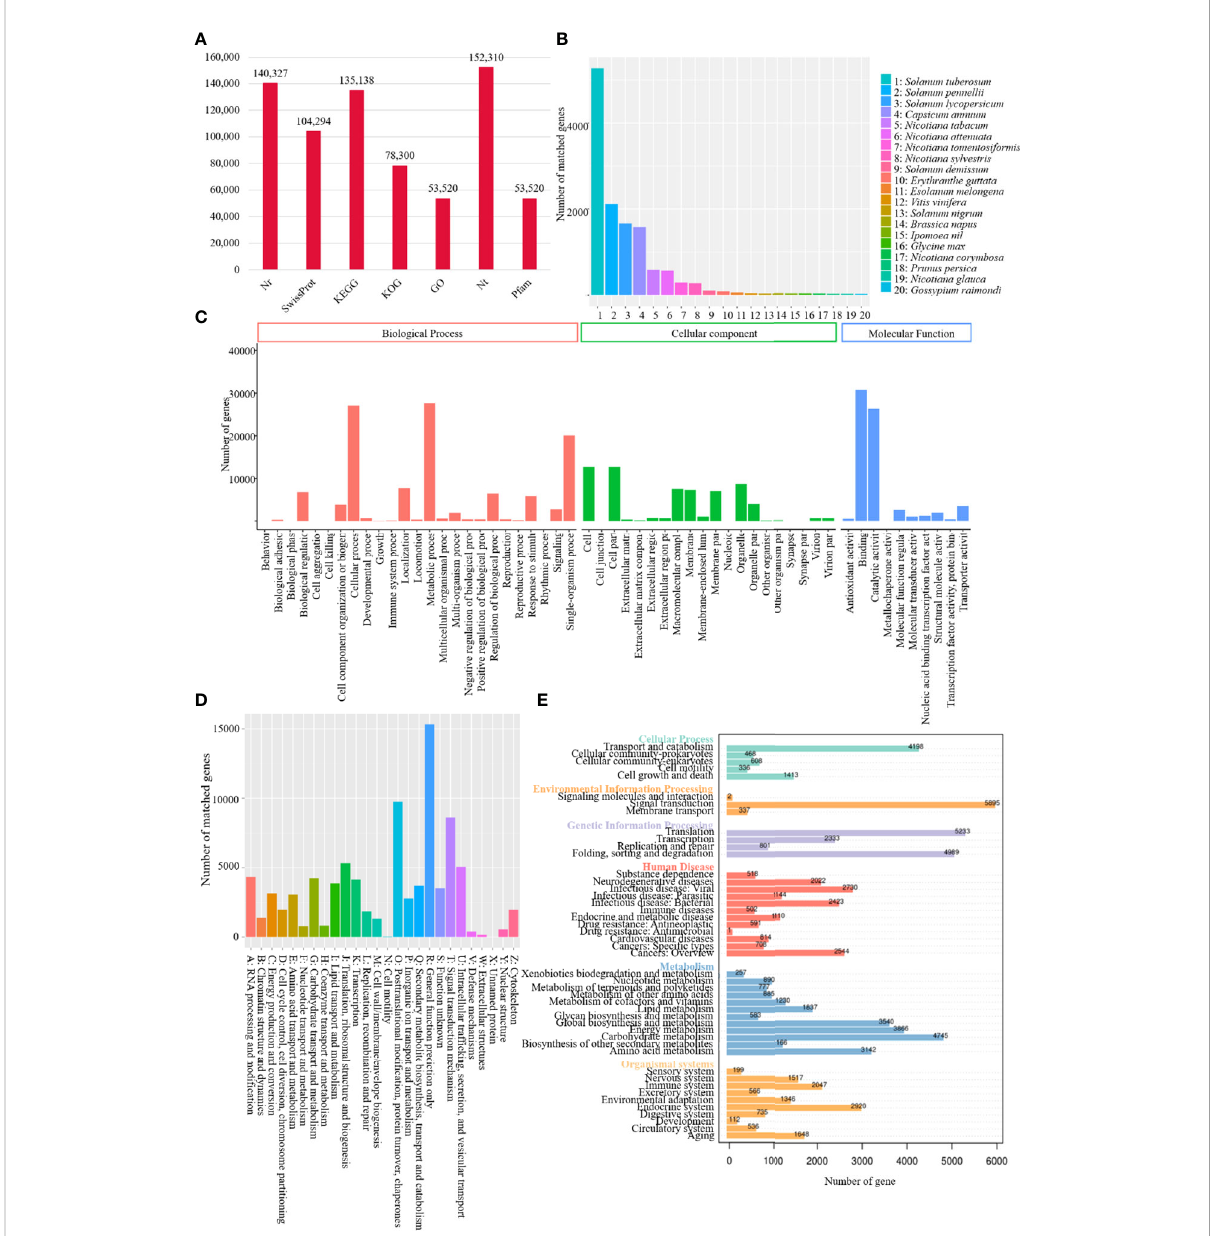
FIGURE 1 Functional annotation of tree tomato full-length transcriptome. (A) Bar chart demonstrating tree tomato annotated number of genes in different databases; (B) homologous species distribution of tree tomato transcripts annotated in Nr database; (C) distribution of GO terms for all tree tomato annotated transcripts; (D) KOG classi fi cation of tree tomato transcripts; (E) KEGG enrichment of tree tomato